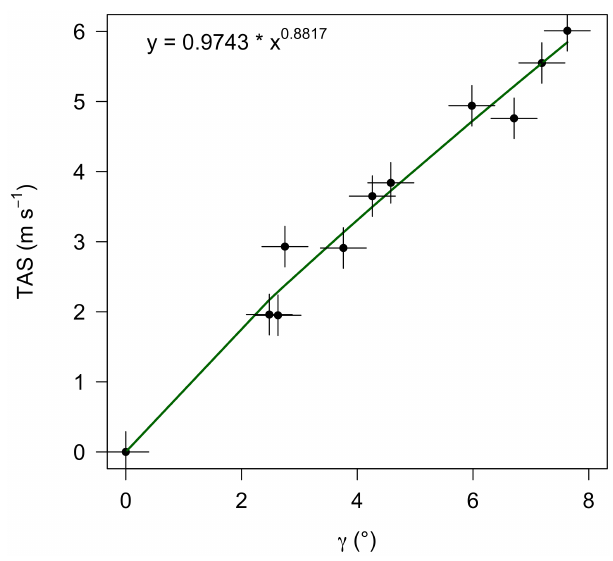
Figure 4. Regression function of relationship between true air speed (TAS) and tilt angle ( γ) experimentally determined with racetrack flights during calm wind conditions. The green line represents the fitted regression function and the error bars indicate the standard deviation of ± 0 . 4 ◦ for the tilt angle and ± 0 . 3ms − 1 ,